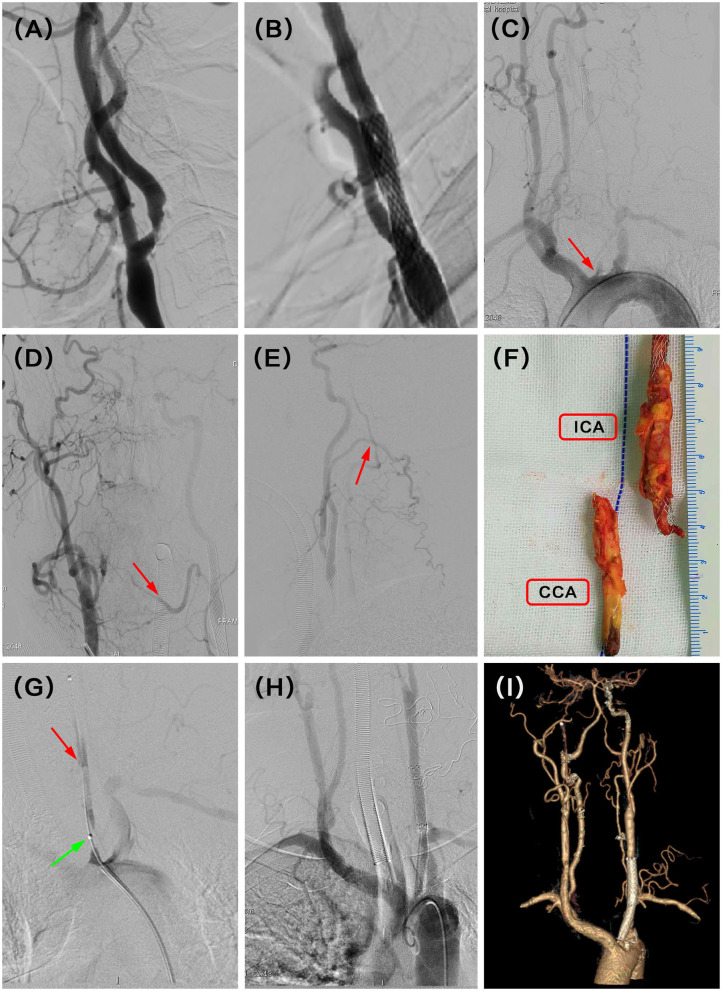
(A) Severe stenosis of the left proximal internal carotid artery (ICA) was observed in the digital subtraction angiography (DSA). (B) Revascularization was achieved with balloon and stent angioplasty. (C) DSA showed recurrent left proximal common carotid artery (CCA) occlusion at the 30 months follow-up (red arrow). (D) Intraoperative angiography demonstrated that complementary inflow was reconstituted by collaterals from right lingual branches (red arrow). (E) Another complementary inflow was also reconstituted by collaterals from left occipital branches (red arrow). (F) Carotid endarterectomy (CEA) combined with Fogarty balloon thrombectomy was performed to remove the plaque with a stent, and the stent was seen clearly in the gross specimen. (G) After that, intraoperative angiography in the beginning of CCA showed tandem severe stenosis (green arrow) and dissection (red arrow) at the proximal and median CCA, respectively. (H) Successful recanalization was then achieved with further stent angioplasty with balloon dilation. (I) CT angiography (CTA) indicated the patency of the left CCA at the latest follow-up time (6 months) after hybrid surgery.